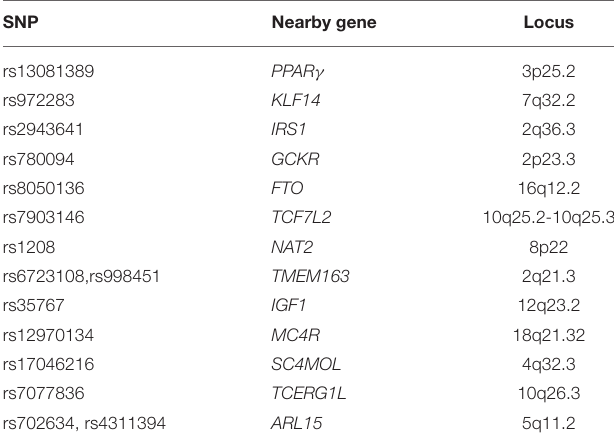
TABLE 3 | Main gene variants associated to insulin